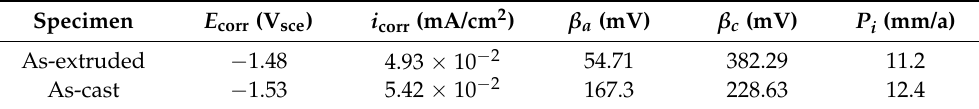
Table 1. Electrochemical parameters of the as-extruded and as-cast alloys obtained from the potentiodynamic polarization test.